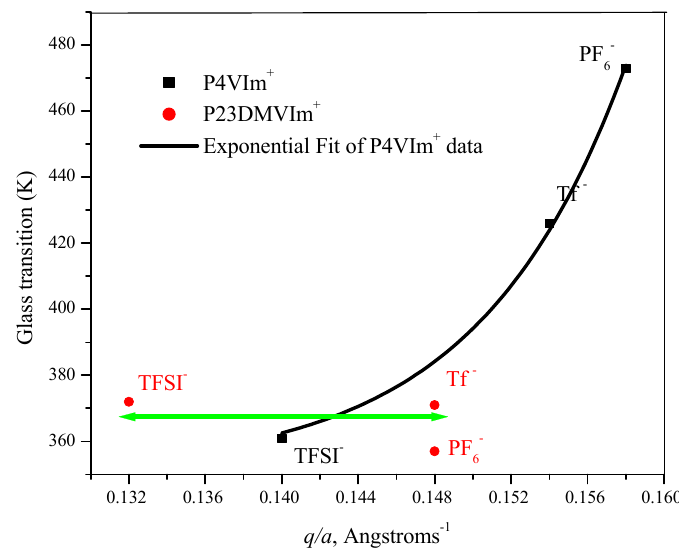
Figure 8. Glass transition temperature (K) versus the ratio of the charge on the ion and the separation between the ion pair, q / a , for poly(1-ethyl-3-methyl-4-vinylimidazolium) and poly1-butyl-2,3-dimethyl-4-vinylimidazolium) salts.